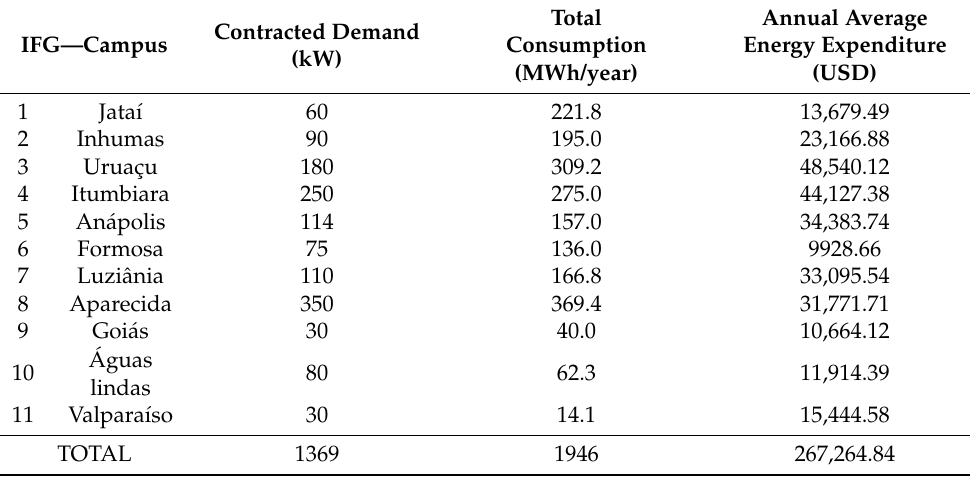
Figure 3. Geographic Locations of the IFG Campuses in the State of Goi á s, Brazil. Table 4. Data on the Consumption, Demand, and Average Energy Expenditure on the IFG Campus in